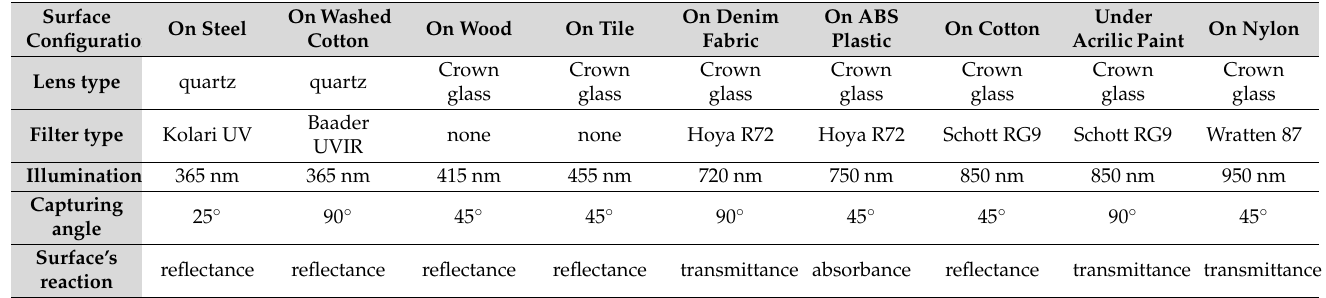
Table 1. Test results for the detection of a drop of human blood -0.05 ml- considering different